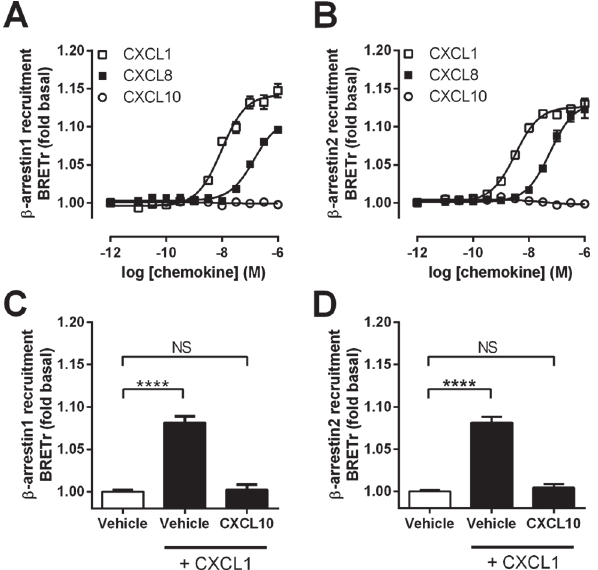
Fig 2. ORF74 recruits β -arrestin1 and β -arrestin2 in response to human chemokines. HEK293T cells co-expressing ORF74-Rluc8 and β -arrestin1-eYFP (A, C) or β -arrestin2-eYFP (B, D) were stimulated with increasing concentrations of CXCL1 (open squares), CXCL8 (filled squares) or CXCL10 (open circles) (A, B) or co-stimulated with CXCL1 and CXCL10 (C, D). β -arrestin recruitment to the receptor was measured as an increase in BRET ratio (BRETr). Data are shown as fold over basal and represent the mean of pooled data from at least three independent experiments each performed in triplicate. Error bars indicate SEM values. Significant differences between vehicle and chemokine-stimulation were determined by one-way ANOVA followed by a Bonferroni test ( **** p (cid:1) 0.0001). NS = not significant.